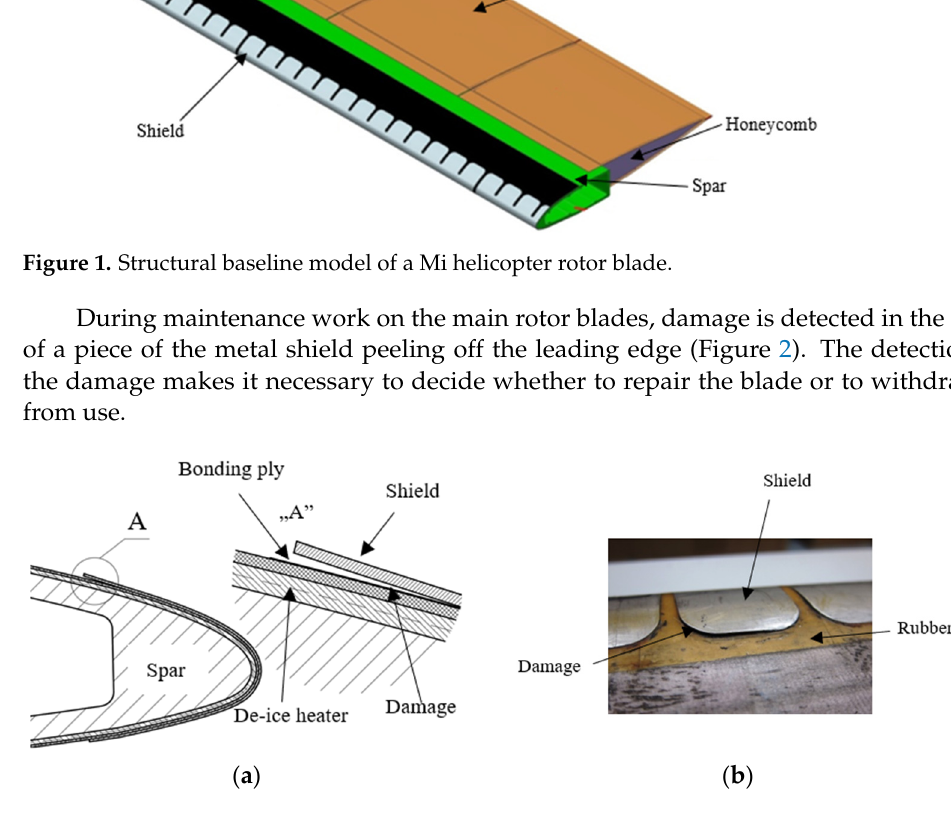
Figure 2. Damage to the leading edge—debonding shield from the leading edge: ( a ) Diagram; ( b ) Damage to a Mi-2 helicopter rotor blade (series 22-2700-3000).